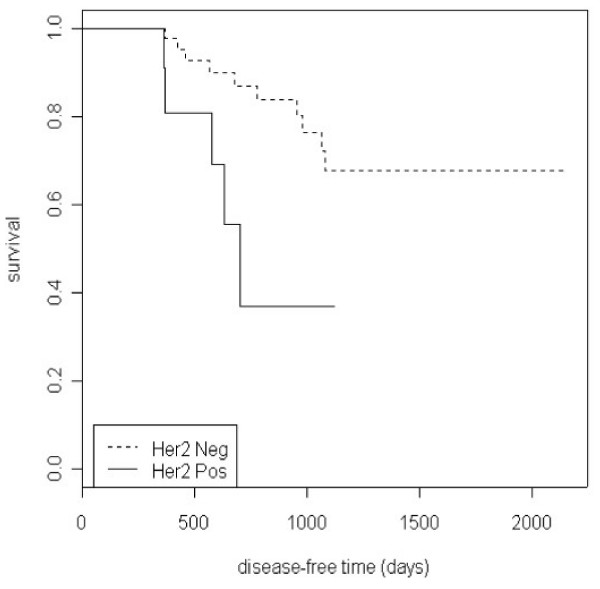
Kaplan-Meiers survival curve, the expression of Her-2/neu receptor was associated with a decrease in disease free time (p = 0.009 Cox model).